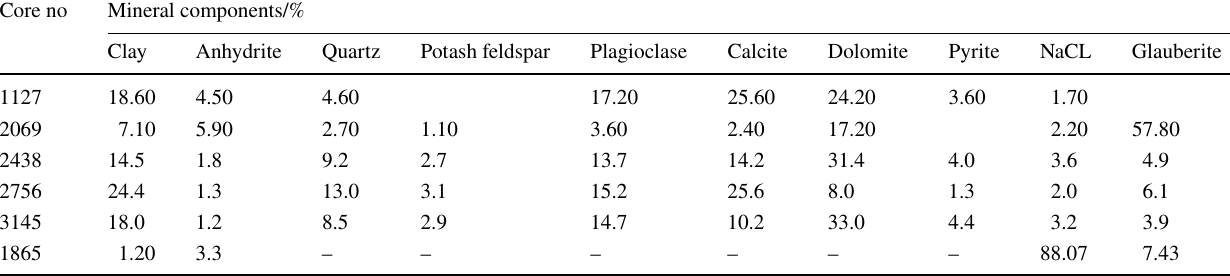
Table 2 The mineral composition of typical lithologic cores Core no Mineral